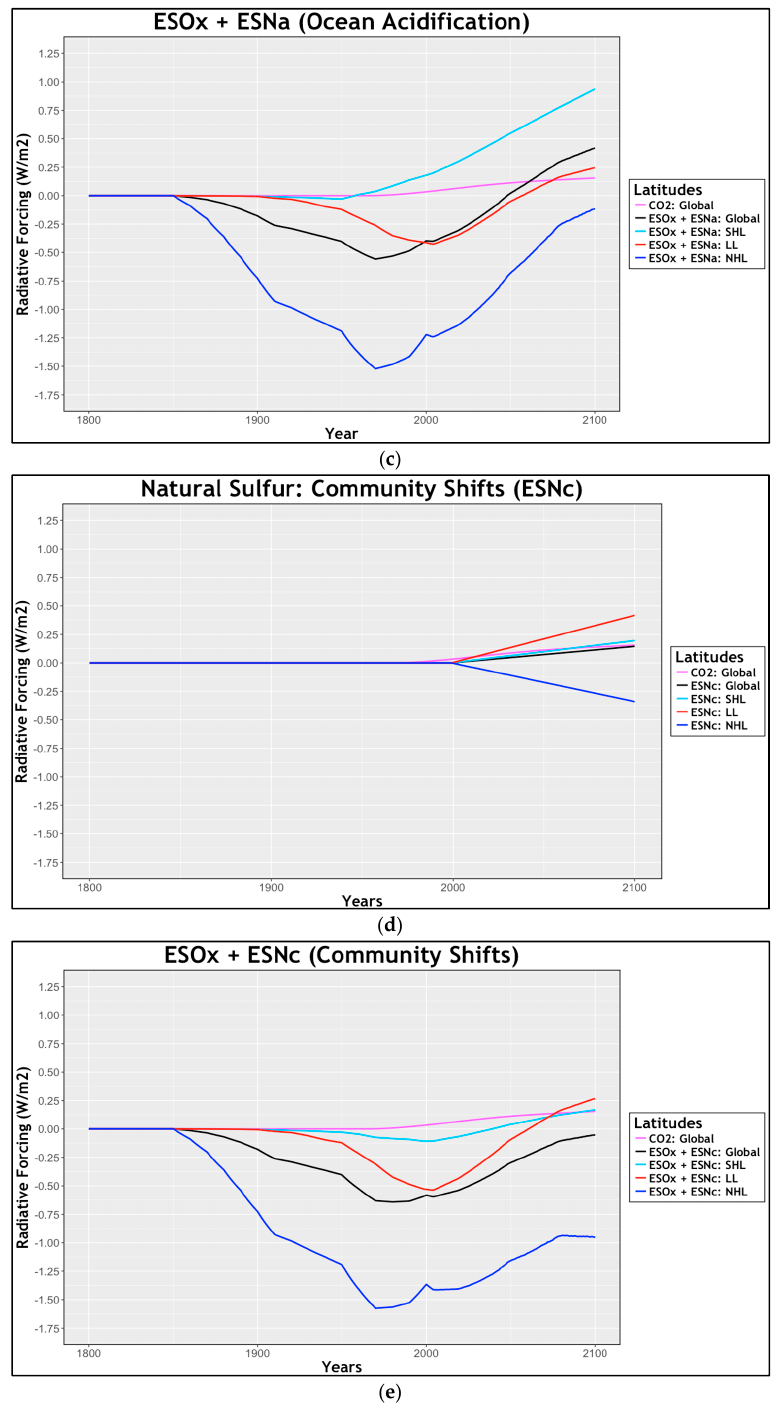
Figure 1. Impacts the sulfur and CO 2 marine biogeochemical (mBGC) feedbacks have on the global radiative forcing budget, from 1800 to 2100. Included in the illustration are CO 2 global impact (pink), global average sulfur impact (black), southern high-latitude sulfur impact (90–30 ◦ S) (light blue), low-latitude sulfur impact (30–30 ◦ N) (red), and northern high latitude sulfur impact (30–90 ◦ N) (blue): ( a ) anthropogenic SO 2 and CO 2 forcings; ( b ) natural influence of sulfur with respect to ocean acidification [6]; ( c ) natural and anthropogenic sulfur forcings taken together while considering acidification; ( d ) natural influence of sulfur with respect to community shifts; ( e ) natural and anthropogenic sulfur forcings accounting for phytoplankton community